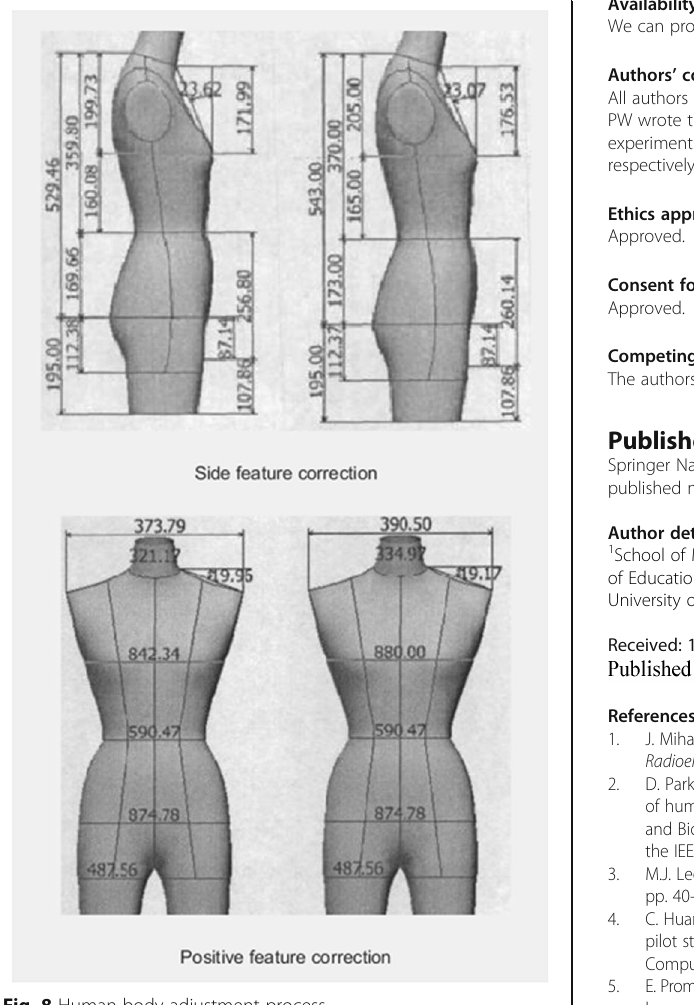
feature curve based on the neural network. The similar three-dimensional human body that is searched in the three-dimensional human body database is a body shape information carrier, and the similar three-dimensional hu- man body deformation is driven by the feature size and curve. The obtained information is merged and divided to quickly generate a three-dimensional personal